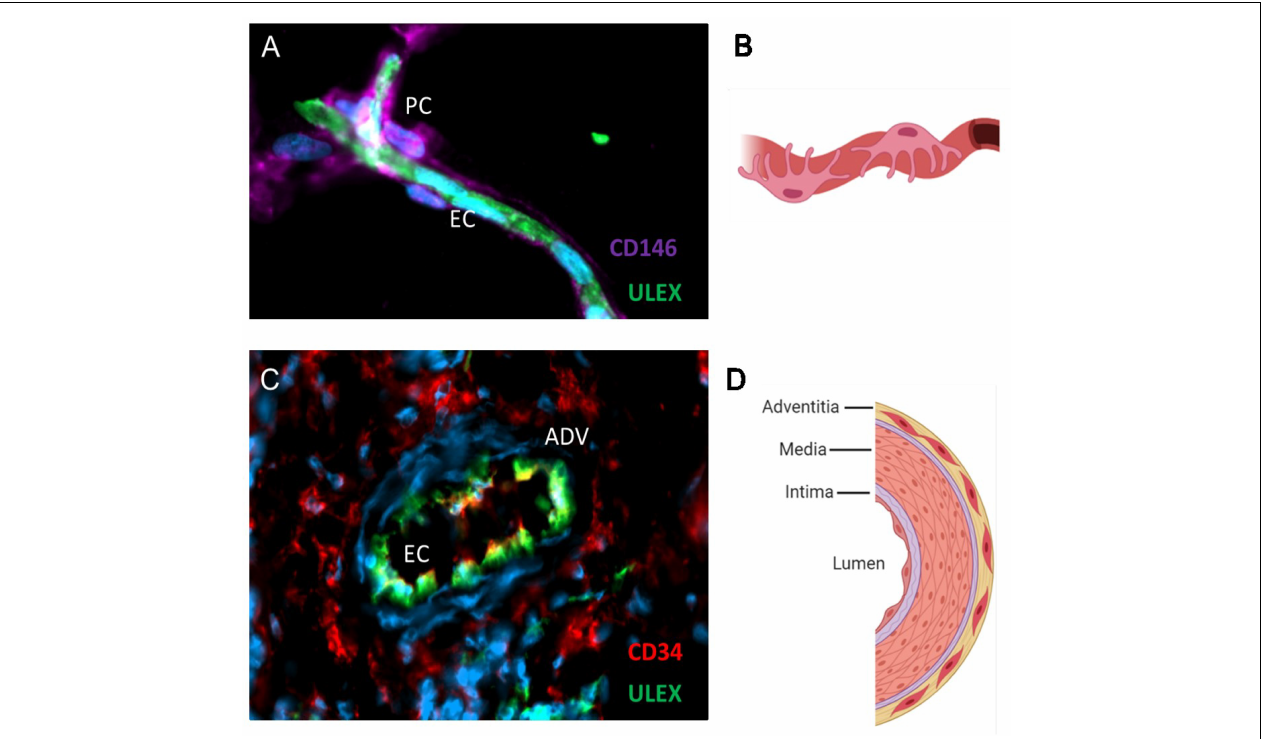
FIGURE 1 | MSC progenitors are located in capillaries and large vessels. Immunofluorescence analysis of adipose tissue (A) and schematic (B) showing pericytes expressing CD146 in close contact with the endothelium stained with the Ulex europaeus lectin. Blue marks DAPI staining of cell nuclei. Adventitial cells expressing CD34 are located in the adventitial layer of veins and arteries (C,D) . Endothelial cells appear yellow/green because they express both CD34 and the Ulex receptor. Schematics were created with